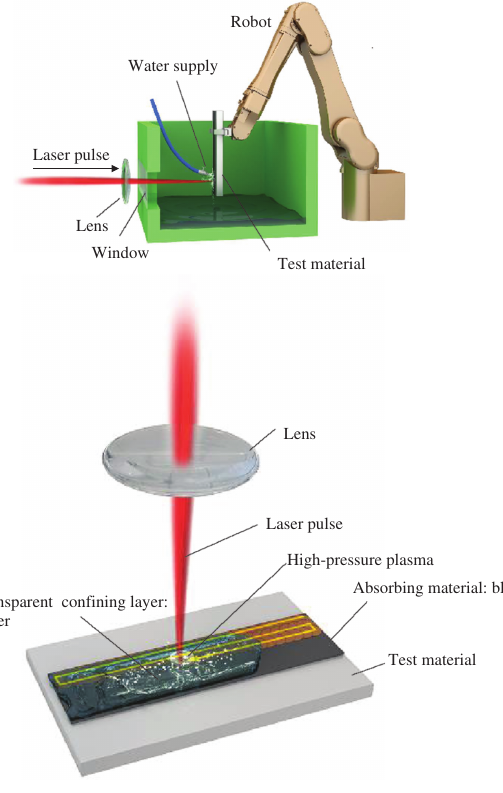
Figure 1: Illustration of process for LSP treatment.